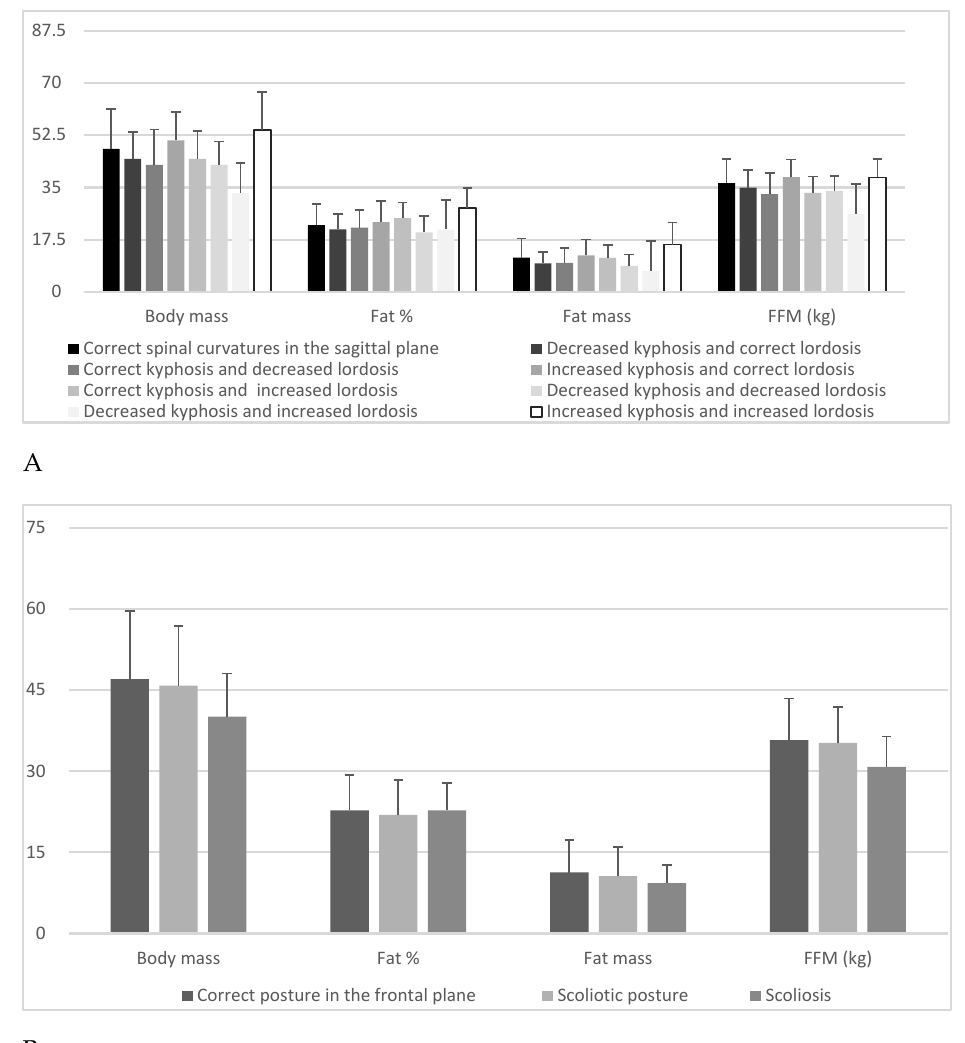
Figure 2. Body mass, fat %, fat mass, fat-free mass and: sagittal spine types ( A ) and correct posture in the frontal plane, scoliotic posture and scoliosis ( B ).